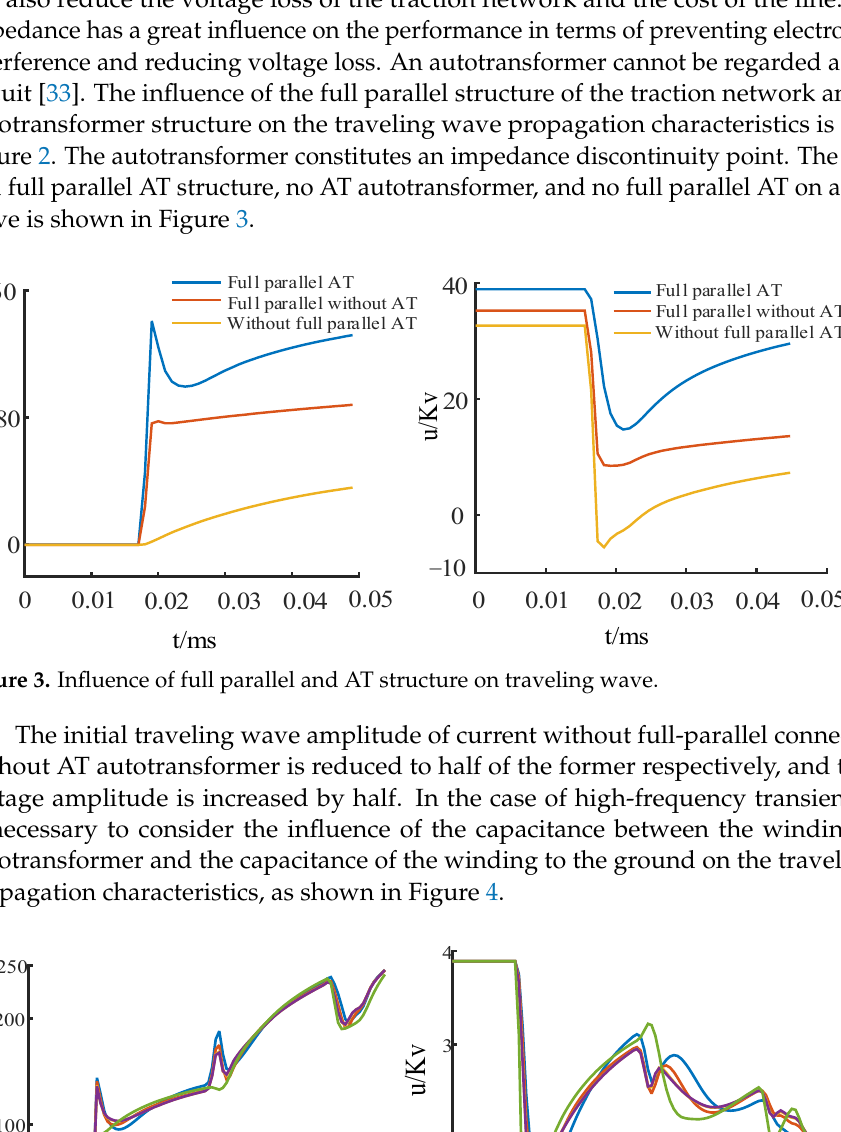
Figure 4. Influence of winding capacitance on traveling wave characteristics.